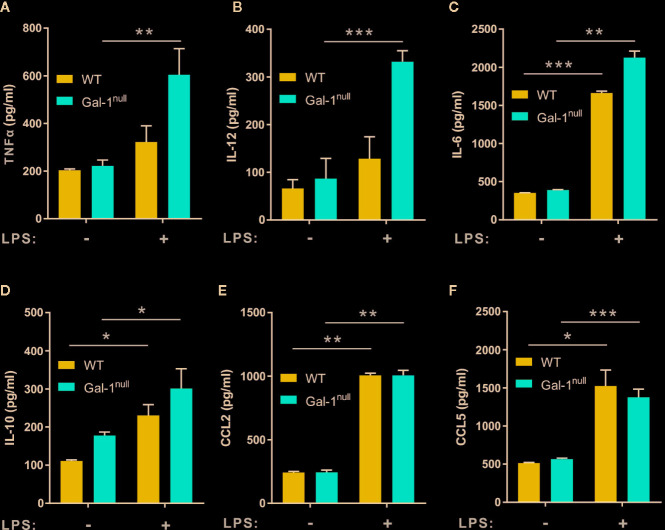
Gal-1null naïve macrophages are more sensitive to LPS stimulation. Peritoneal naïve macrophages were isolated from unchallenged WT and Gal-1null male mice and then exposed to vehicle or LPS for 24 h. The concentrations of the following cytokines and chemokines were measured in the culture media by ELISA: (A) TNF-α, (B) IL-12, (C) IL-6, (D) IL-10, (E) CCL2, and (F) CCL5. Altogether, the data represent two to three independent experiments and are presented as mean ± SEM, n = 4–8. Statistical significance relative to non-stimulated macrophages was analyzed by two-tailed Student's t-test; *p < 0.05, **p < 0.01, ***p < 0.001.